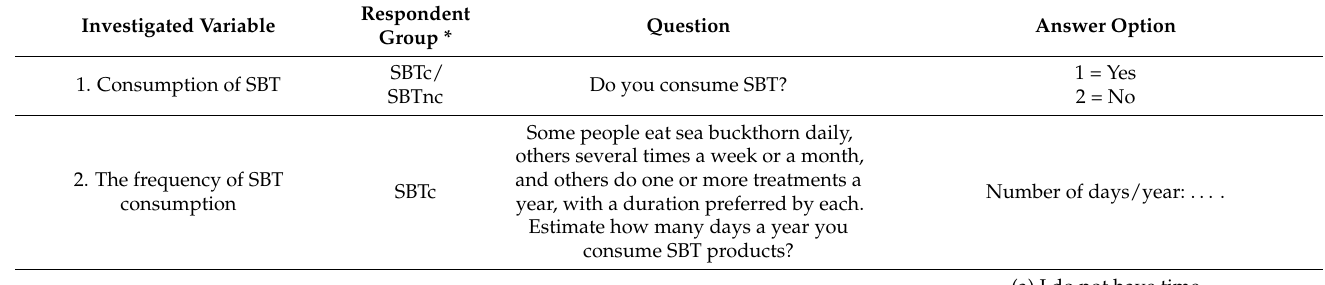
Table A1. Investigated variables, the questions used for each variable in the questionnaire for each group (SBT consumers and non-consumers), and the answer options presented to